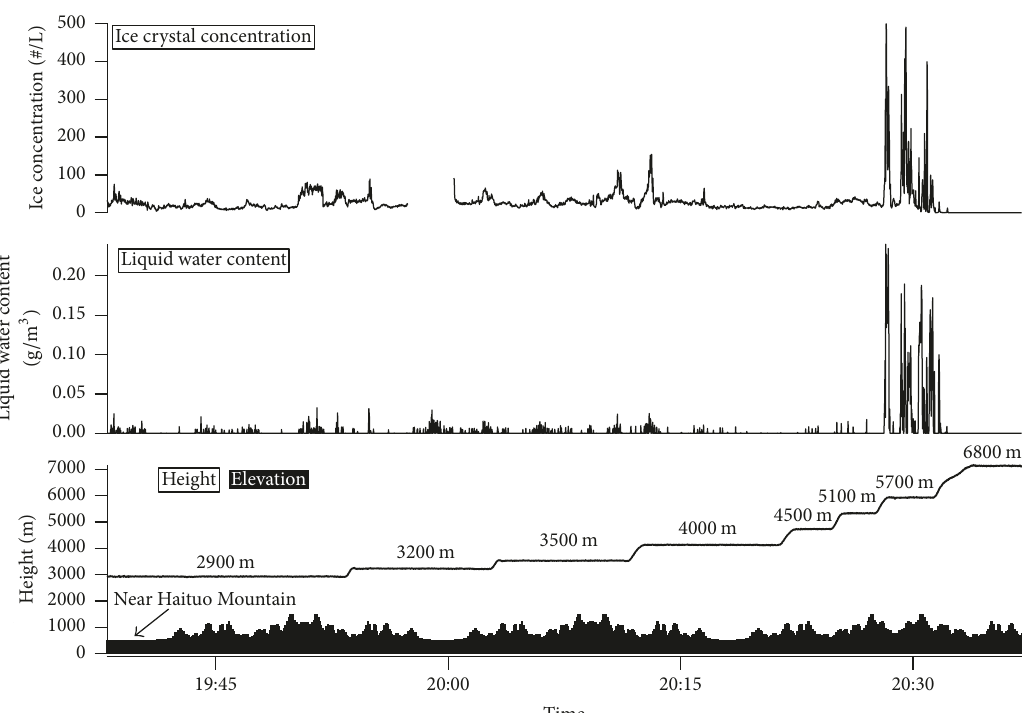
Figure 9: Liquid water content and ice concentration at different altitudes in case 1. (Black shade is the ground elevation under the flight